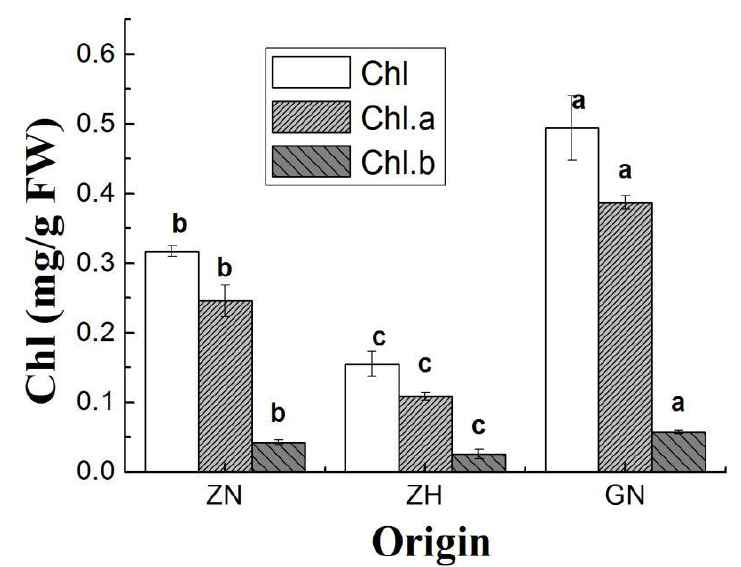
Figure 1. Total chlorophyll, chl. a, and chl. b contents of Kandelia obovata seedlings. FW stands for sample fresh weight . Different letters indicate significant difference among origin at the same sampling time according to one-way ANOVA at P < 0.05. GN: normal leaves from Zhanjiang, Guangdong; ZH: the half-wilted leaves from Zhoushan, Zhejiang; ZN: the normal leaves from Zhoushan, Zhejiang.